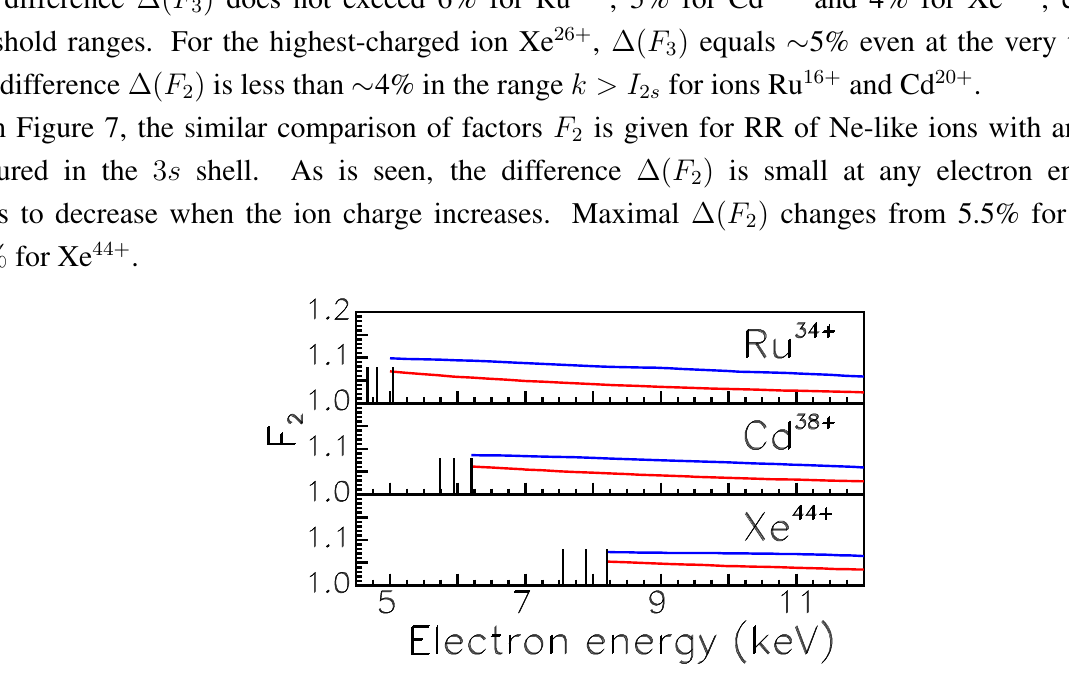
for the capture in the 3 s states of the Ne-like ions. 2 , 2 p and 2 s states (from left to right) obtained by the 3 / 2 1 / 2